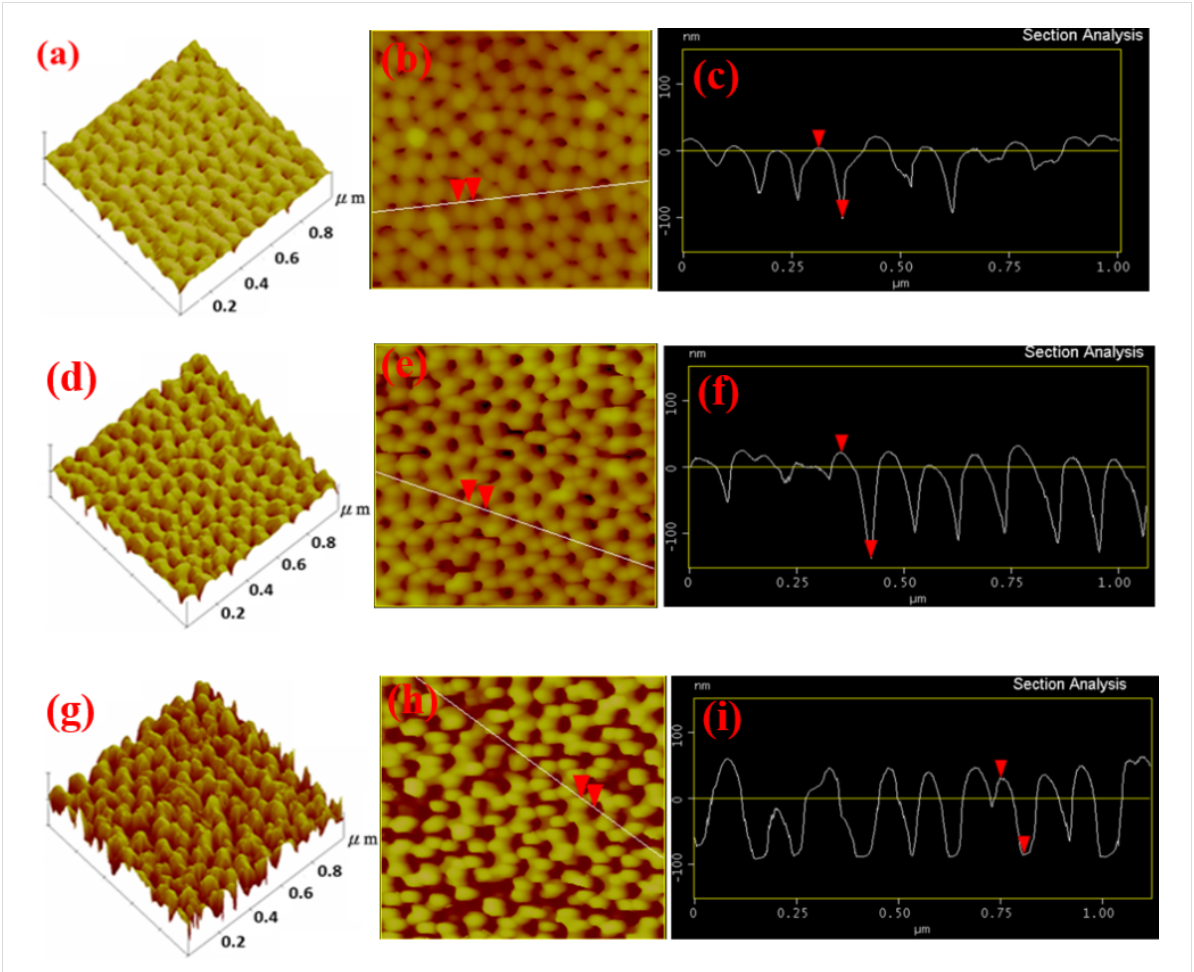
Figure 2: Atomic force microscopy measurements for samples (a–c) AAO60, (d–f) AAO70, and (g–i) AAO80.